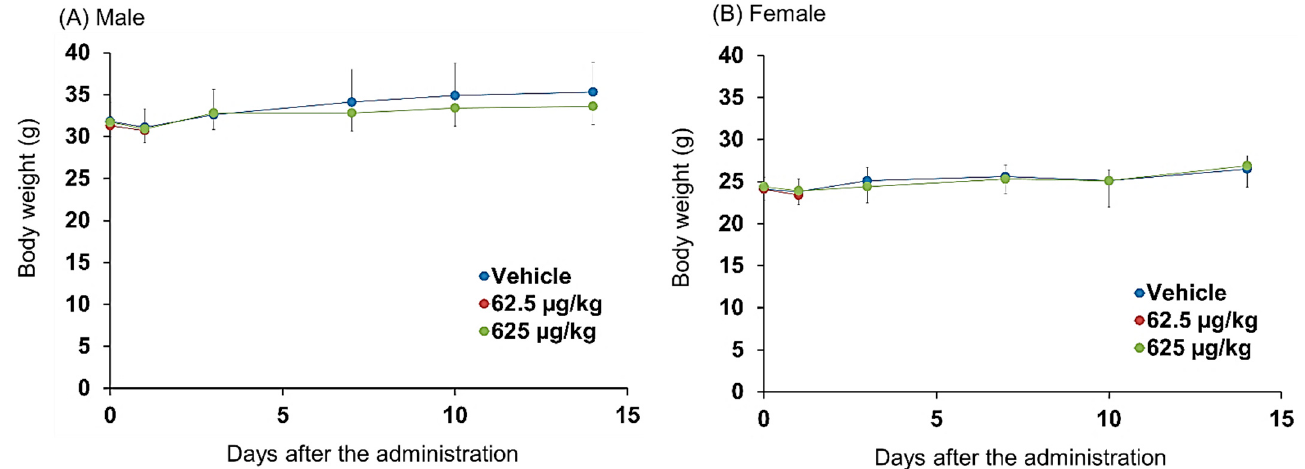
Figure 4. Changes in the body weights of mice after the intraperitoneal administration of Cu- NCAB001. Plots of the average body weight of ( A ) male and ( B ) female mice in each treatment group of the extended single-dose toxicity study are shown. Values are presented as mean ± SD. The means were calculated based on the following number of values: days 0 and 1, vehicle and 625 µ g/kg groups, n = 15; 62.5 µ g/kg group, n = 10; day 3 and thereafter, vehicle and 625 µ g/kg groups, n = 5. As there were no significant differences in histopathological observations between the 625 µ g/kg-treated and control groups on day 1, the 62.5 µ g/kg-treated group was not subjected to the assessment of body weight from day 2 to day 14. No statistically significant changes were observed.